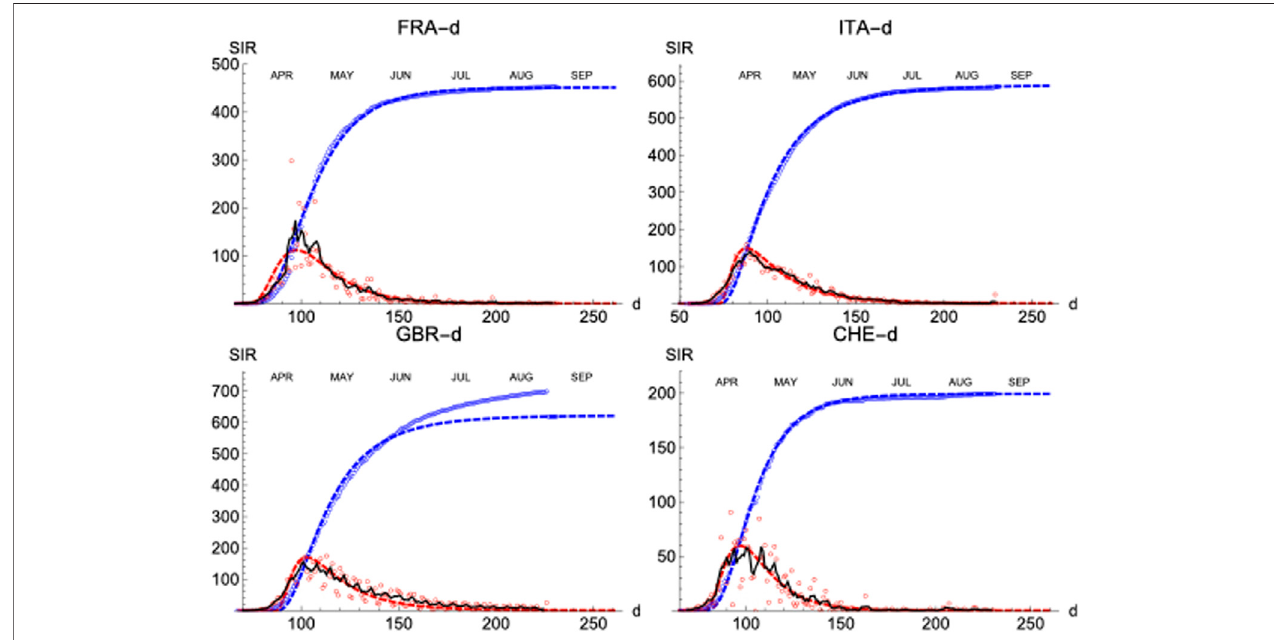
FIGURE 10 | SIR (deaths)/FRA, ITA, GBR, and CHE. Respectively left to right and top to bottom. Symbols and lines as in Figure 8 .